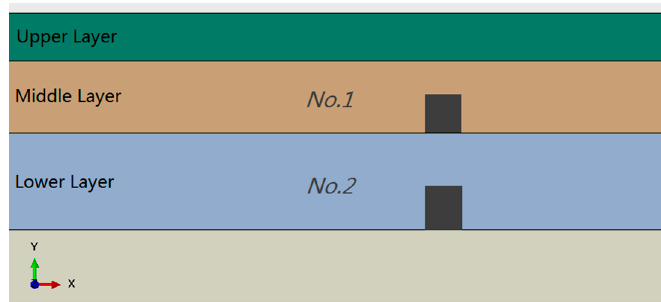
Figure 15. Placement of vertical sensors.